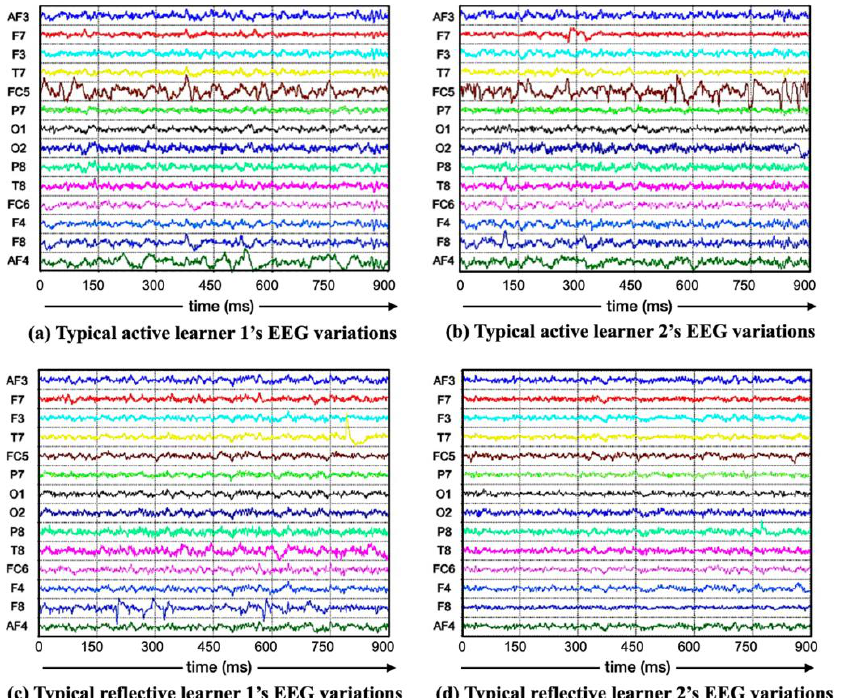
Figure 6. Visualization of EEG responses of LSEEG dataset.